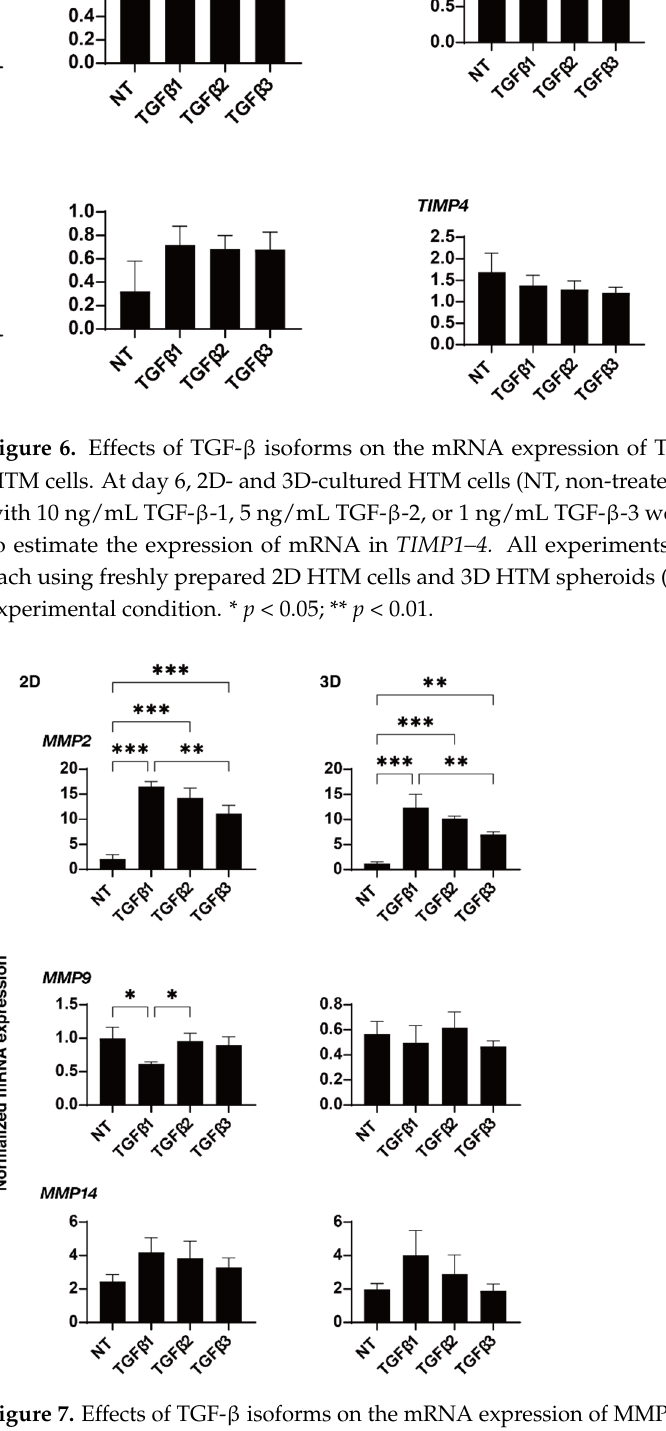
Figure 7. Effects of TGF- β isoforms on the mRNA expression of MMPs in 2D- and 3D-cultured HTM cells. At day 6, 2D- and 3D-cultured HTM cells (NT, non-treated control) and cultures treated with 10 ng/mL TGF- β -1, 5 ng/mL TGF- β -2, or 1 ng/mL TGF- β -3 were subjected to qPCR analysis to estimate the expression of mRNA in MMP 2 , 9, and 14 . All experiments were performed in